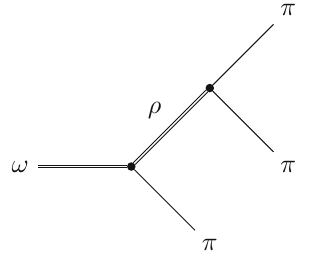
Fig. 3 VMD tree-level diagram for ω → 3 π given by a ω → ρπ and a subsequent ρ → ππ